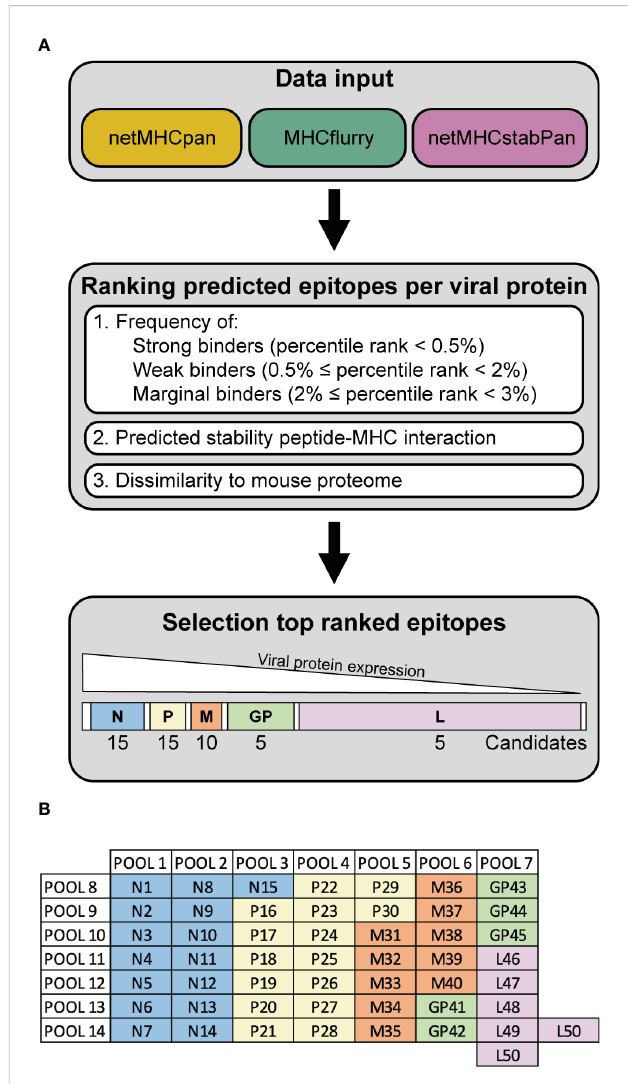
FIGURE 1 Work fl ow VSV-GP epitope predictions. (A) Schematic representation of the steps of the epitope prediction work fl ow. (B) Exemplary peptide candidate matrix for both H2-Db and H2-Kb. For additional information on epitope predictions, see Supplementary Figure